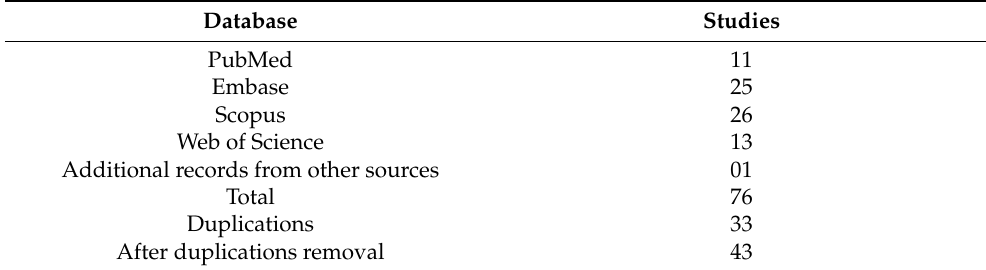
Table A1. Results of the search